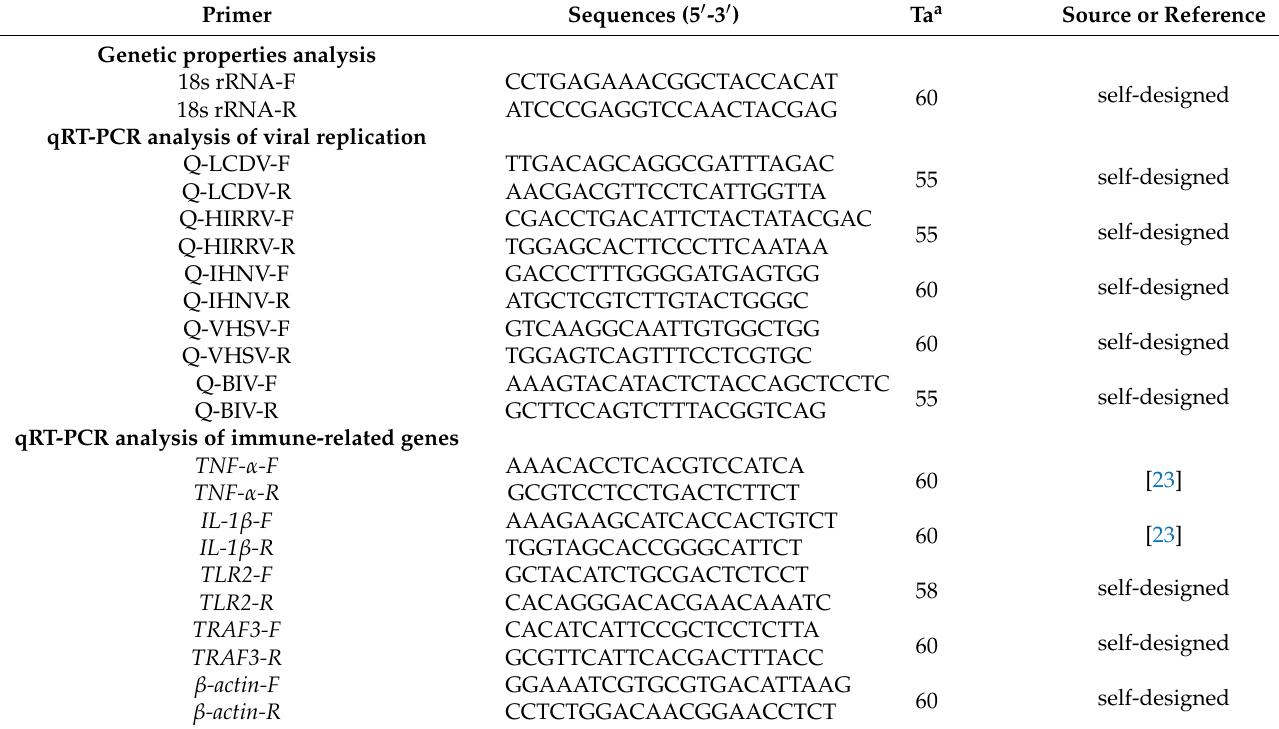
Table 1. Primers used in this